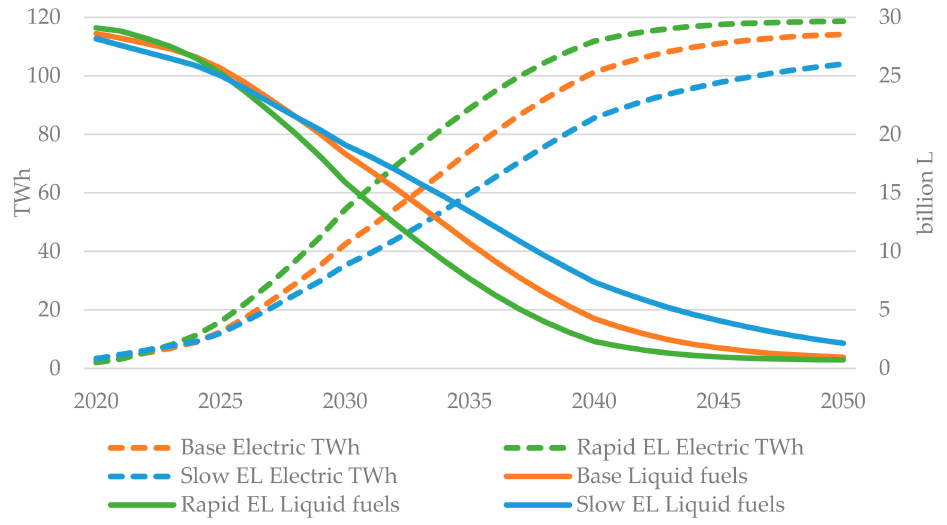
Figure 6. Nordic use of fuels in the transport sector, by scenario.